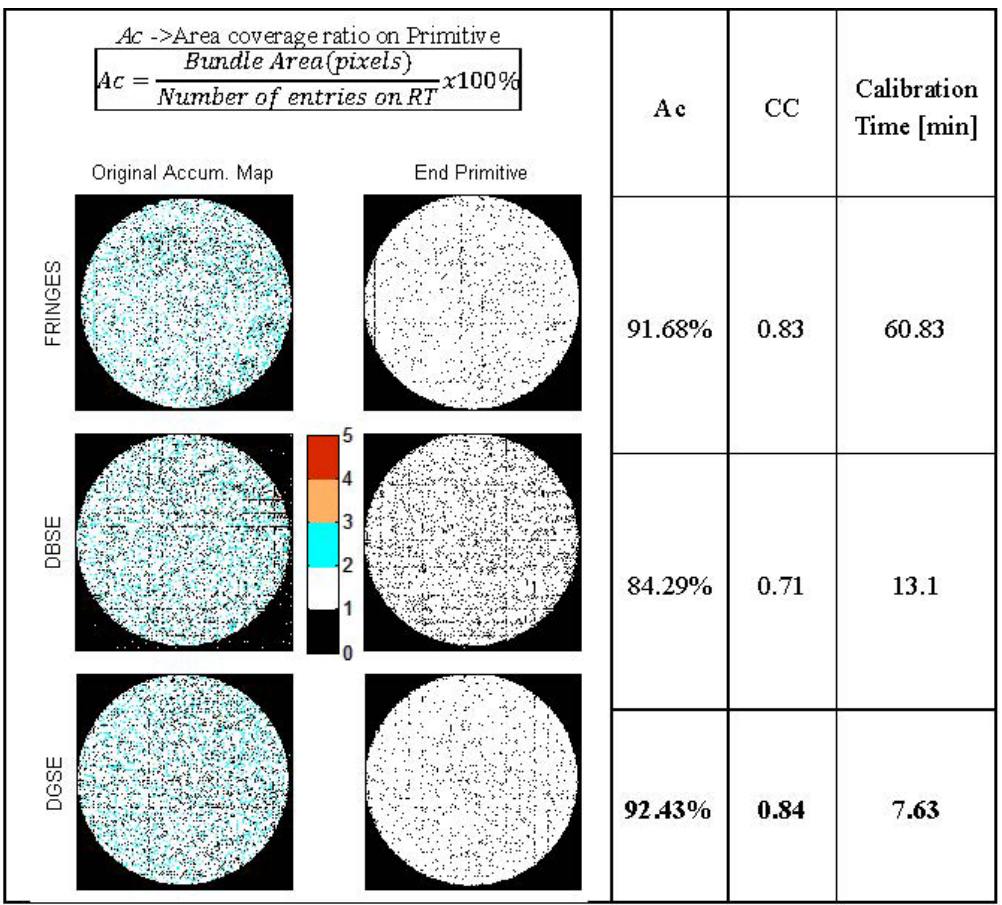
Figure 8. RAMs and Primitive Images for different methods .